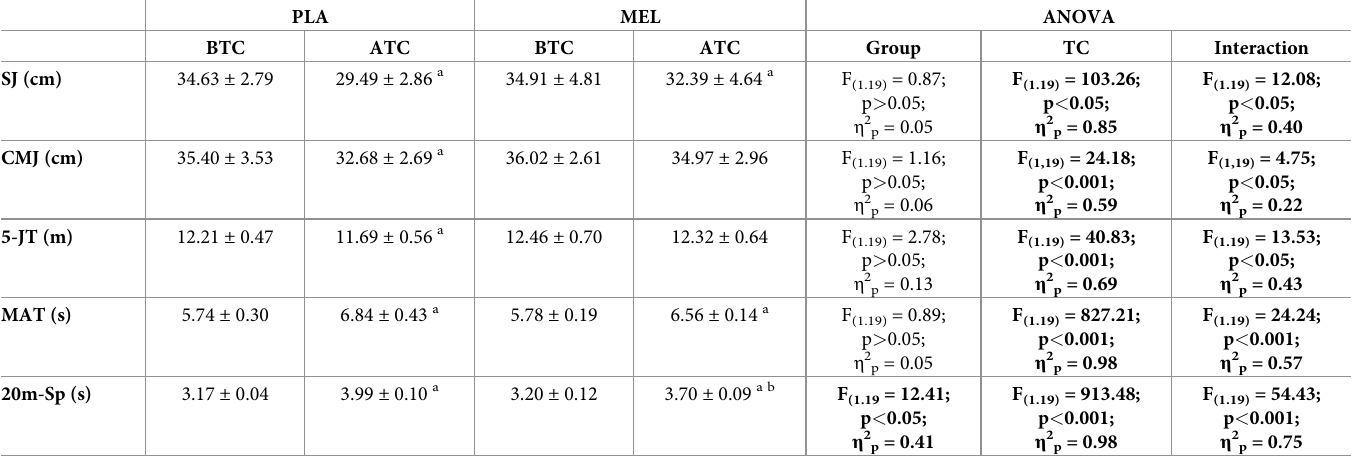
Table 4. Physical performance measured before (BTC) and after (ATC) the training camp (TC) following melatonin (MEL) or placebo (PLA)